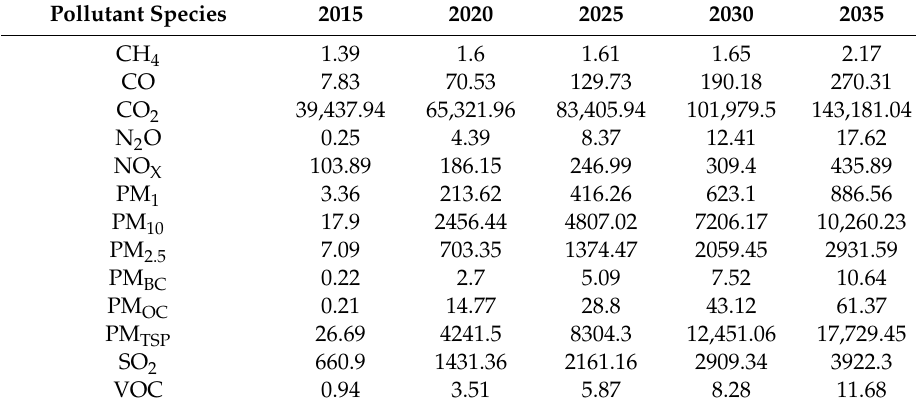
Table 5. Air pollutants emissions in the RE-30 scenario (kton).